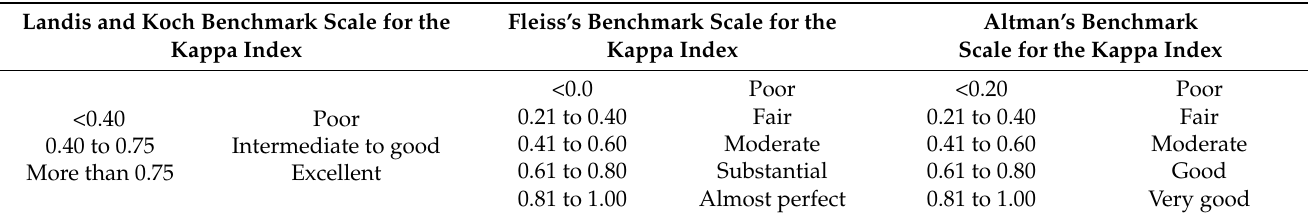
Table 1. Thresholds for the strength of agreement that have been constructed for Kappa in literature. Landis and Koch Benchmark Scale for